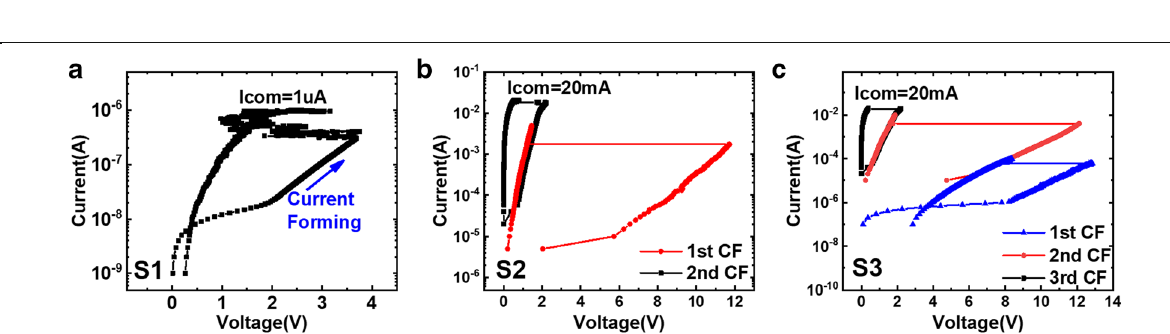
Fig. 4 Current forming process of the Pt/HfO2/TiO x /Pt RRAM device in a S1, b S2, and c S3